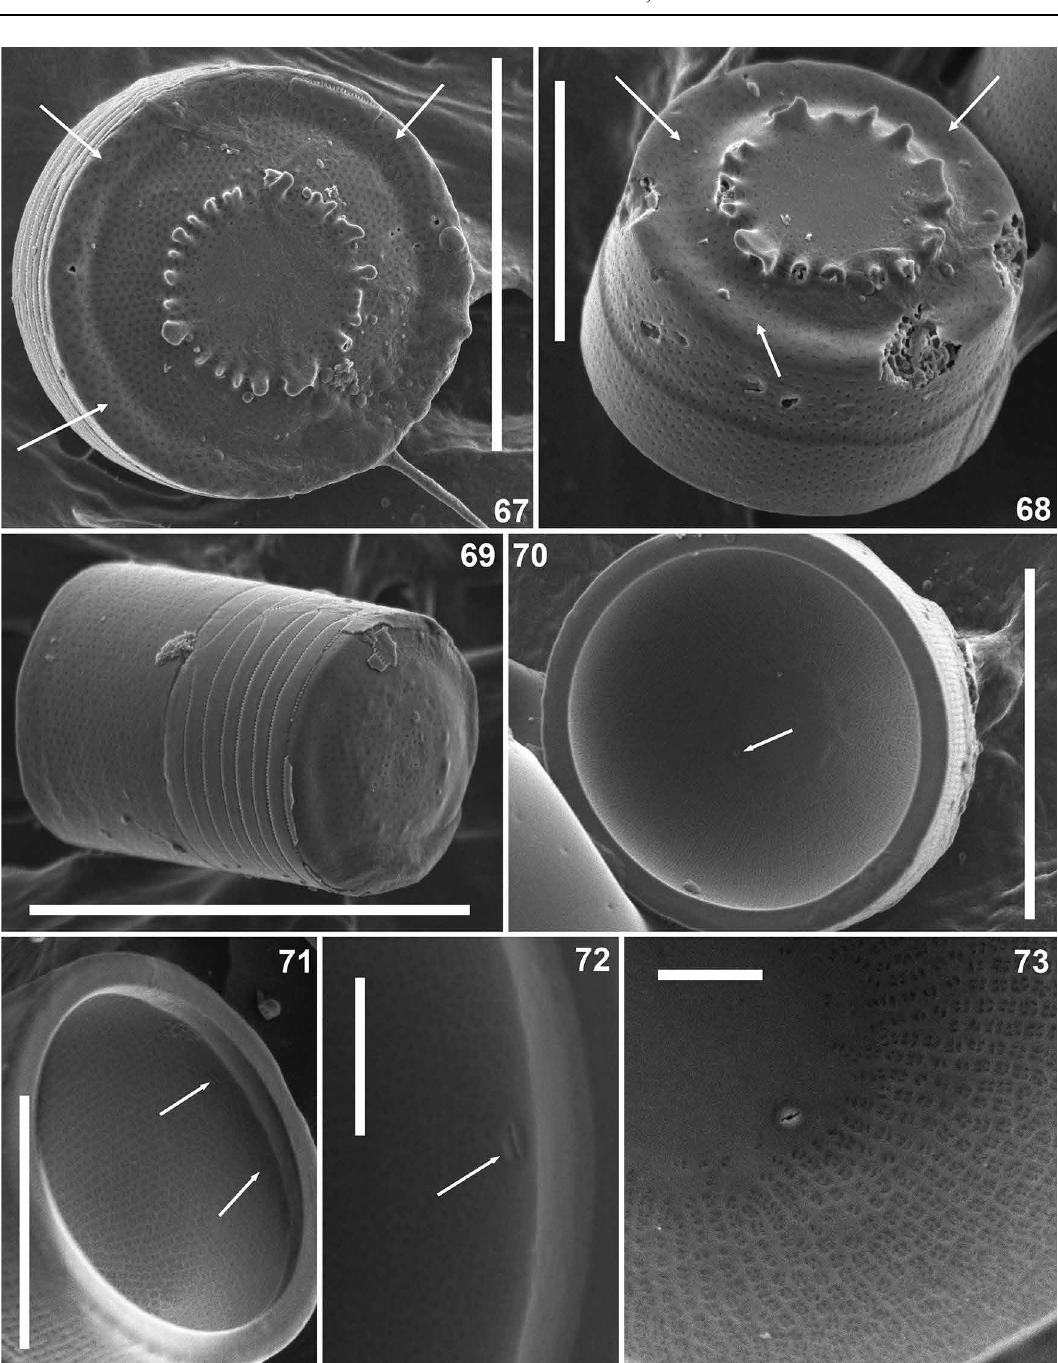
Figs 67–73. Ferocia houkiana Goeyers & Van de Vijver sp. nov. SEM. Campbell Island holotype population, sample BAS284 (BR-4578). 67–68 . Two external valve face views with the typical spines, the rounded to slit like areolae and the Müller step. 69 . External girdle view of a valve lacking the typical central ring of spines. Note the spines vestiges that are present in the central area. 70 . Internal view of an entire valve showing clearly the central rimoportulae (arrow) and the small central area. 71 . Internal view of an entire valve showing clearly the submarginal rimoportulae (arrows). 72 . Internal detail of the valve with one rimoportula indicated by the arrow. 73 . Internal detail of the valve central area with the central rimoportula. Scale bars: 67, 69–70 = 10 μm; 68, 71 = 5 μm; 72–73 = 1